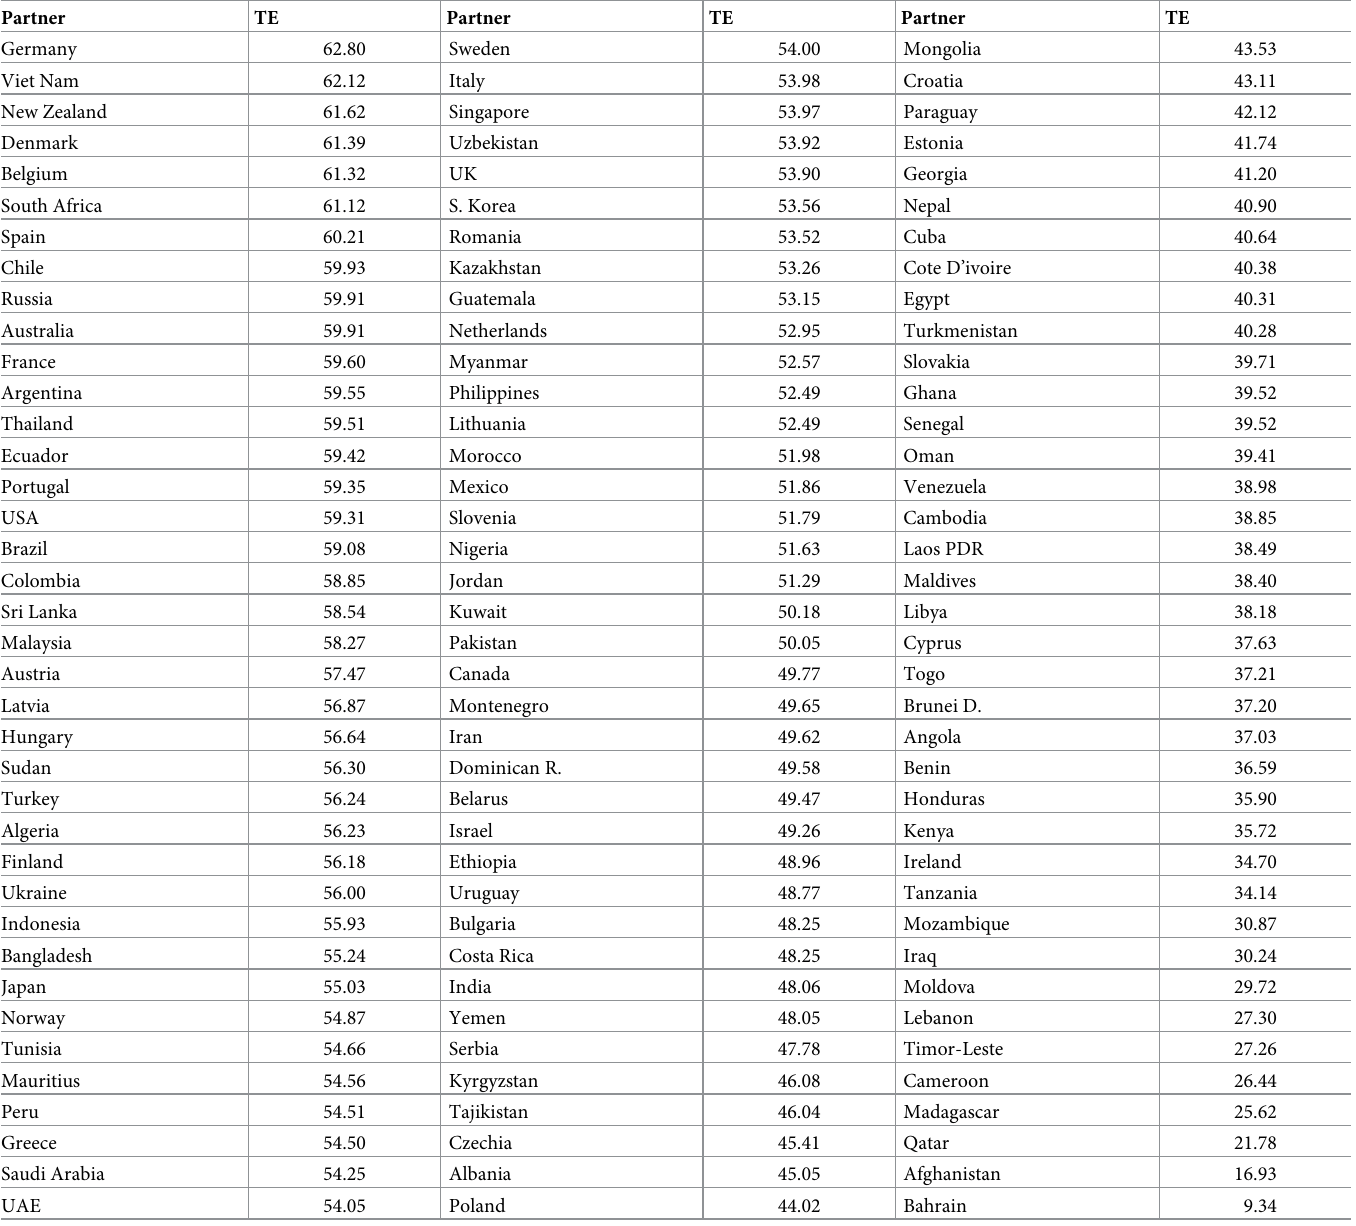
Table 6. Technical efficiency of China’s agriculture exports to major importing partners